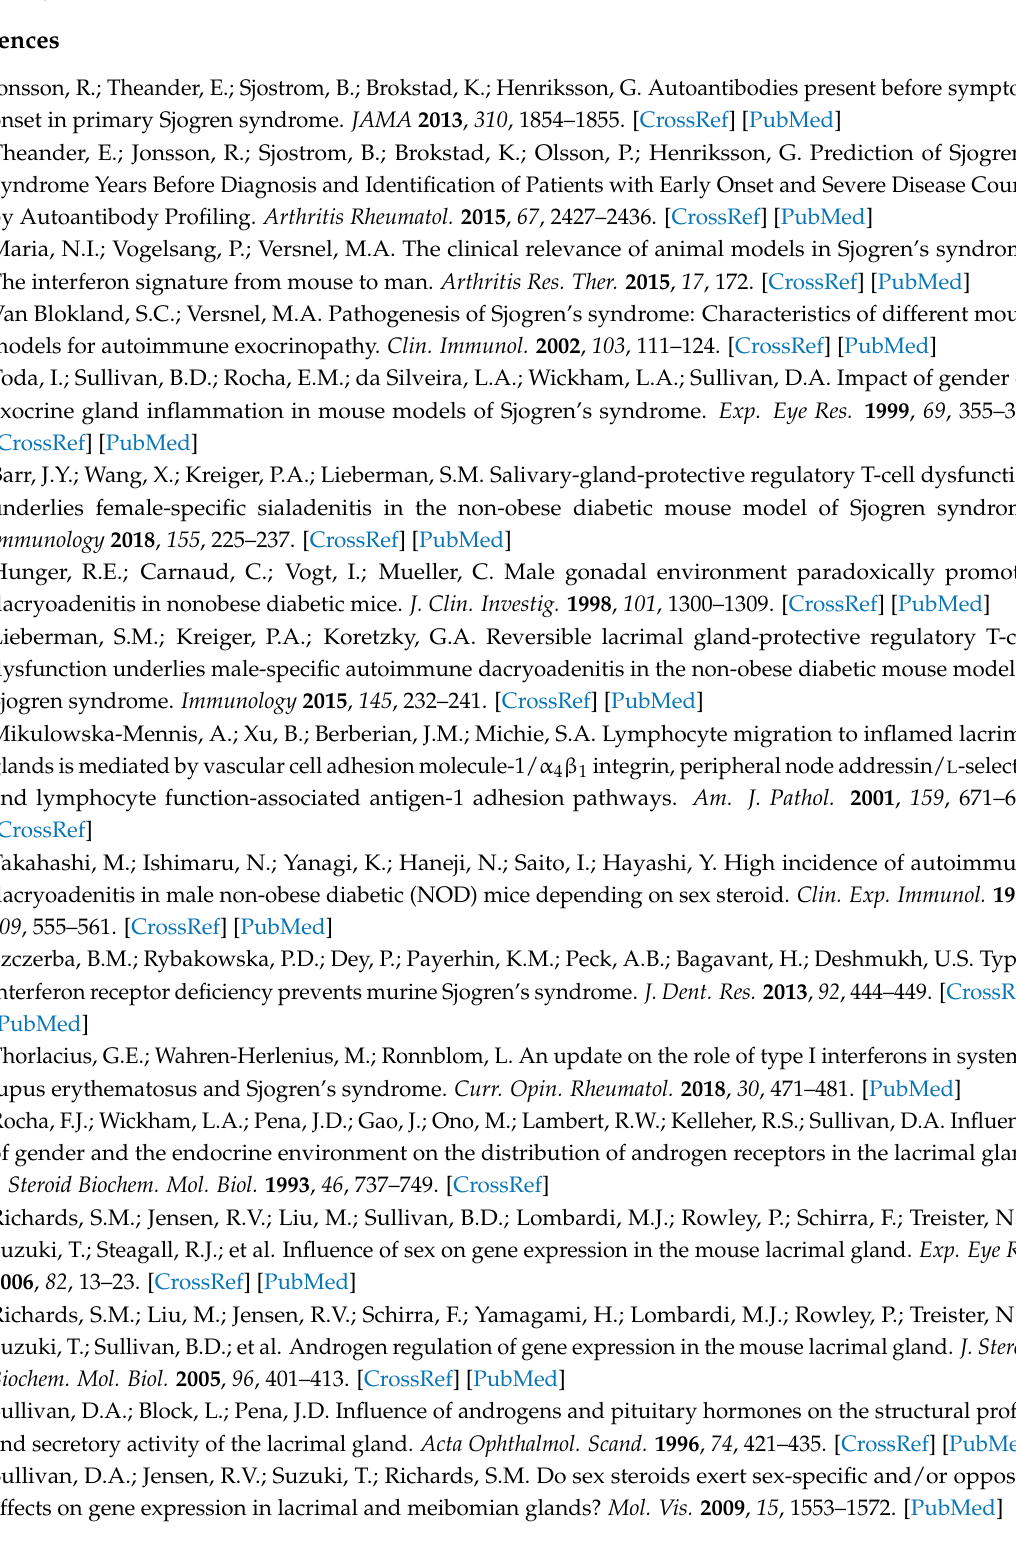
cells as percentage of Tregs (i.e., CD4 + Foxp3 + ) isolated from cervical lymph nodes of mice in Figures 1 and A1A at take-down (10 weeks after initial antibody treatment). Symbols represent individual mice, lines are means, and error bars are standard deviations. p < 0.0001 by one-way ANOVA with individual comparisons corrected for multiple comparisons by Holm-Sidak as indicated: * p < 0.05, **** p < 0.0001, ns p > 0.05. Abbreviations: aCD25, anti-CD25; Iso, isotype; Castr,